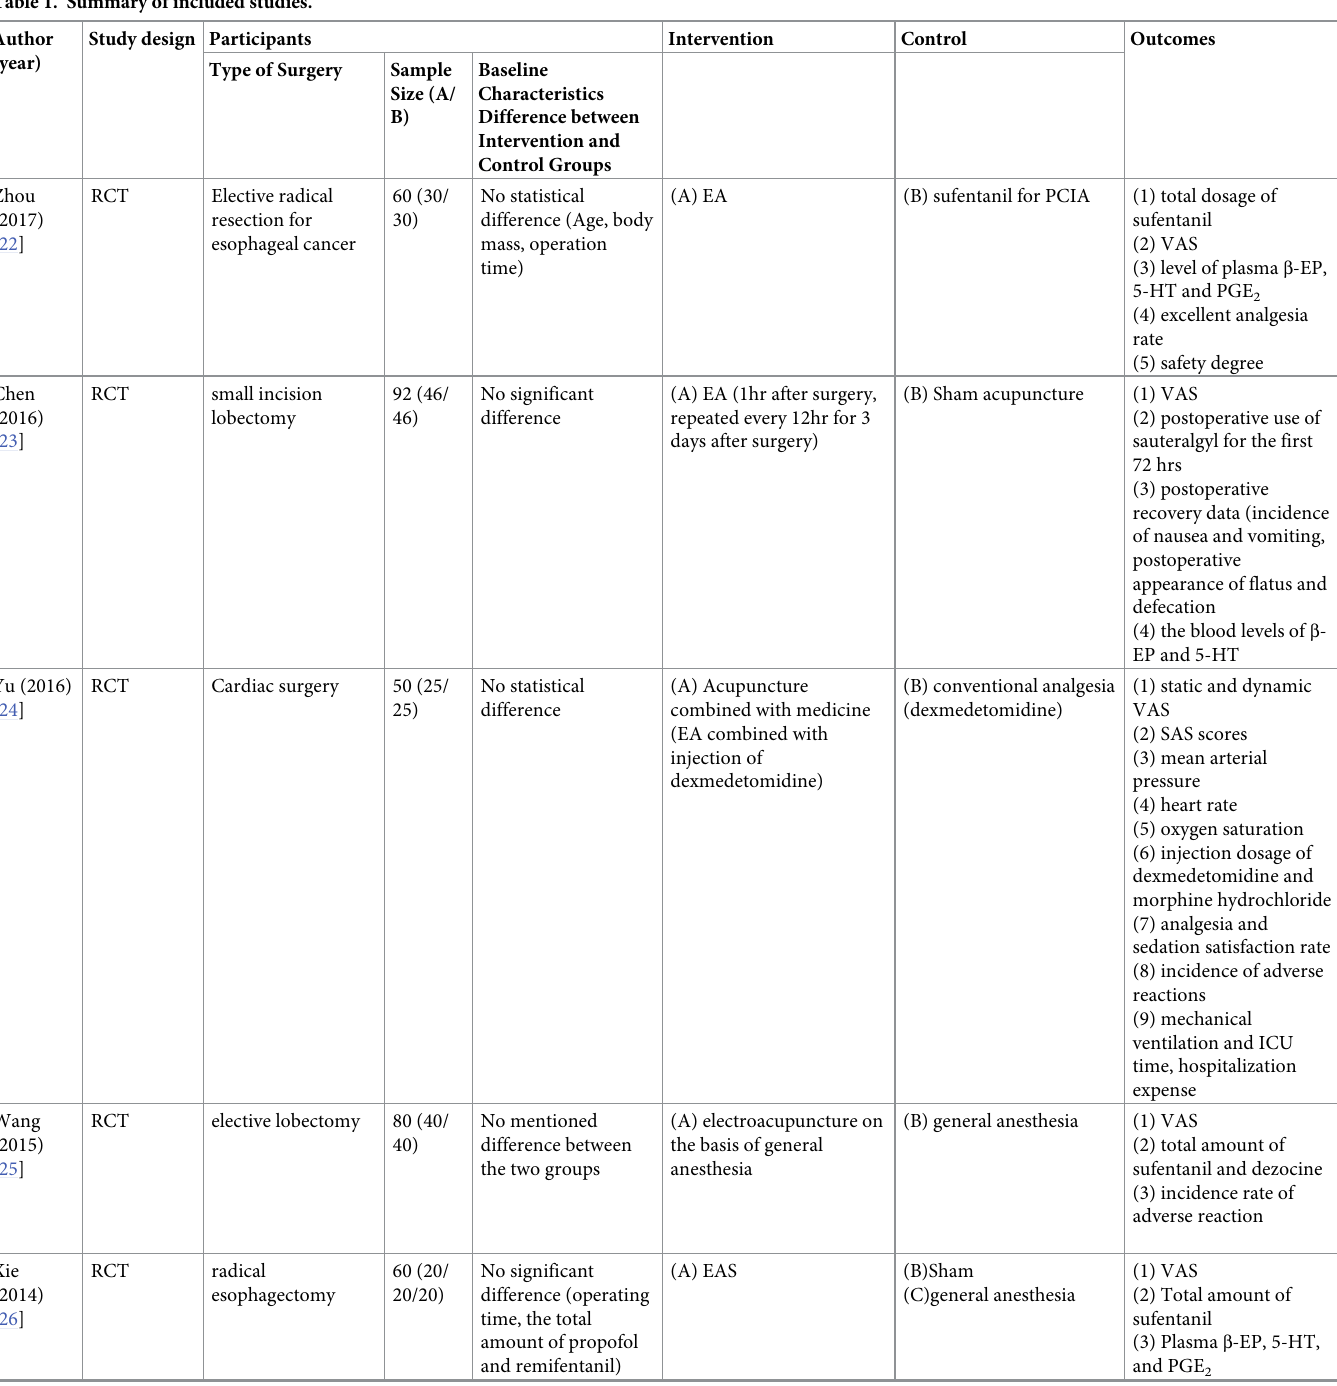
Table 1. Summary of included